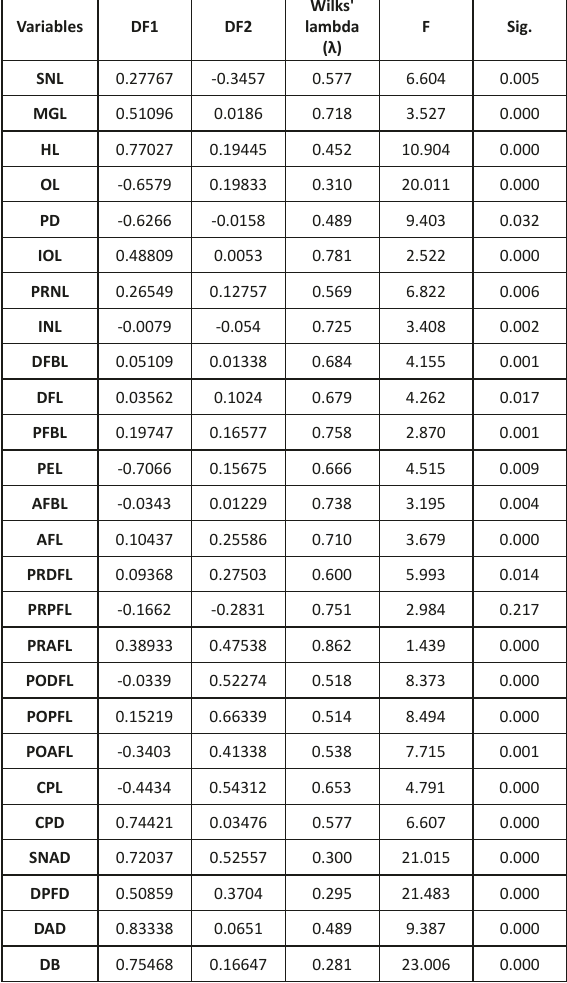
Table 6. Discriminant function analysis for Tetraodontidae — loading scores on the discriminant functions DF1 & DF2 and discriminatory power of morphometric characters Wilks’ lambda (λ), F value & significance.